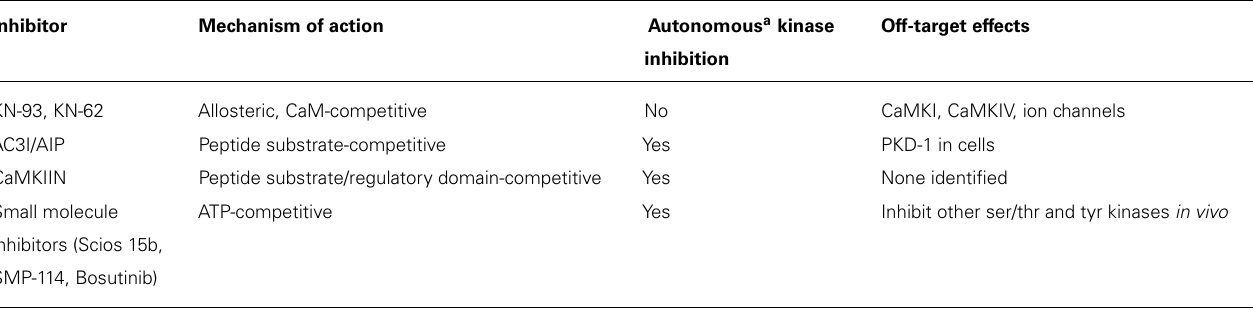
Table 2 | Biochemical properties of best characterized CaMKII inhibitors.